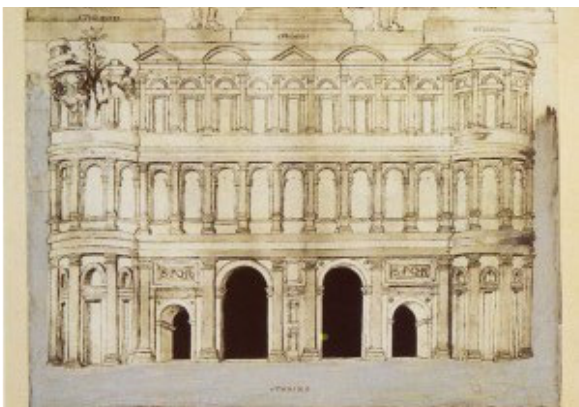
Figure 1 . Giuliano da Sangallo. Survey of Porta Marmorea,